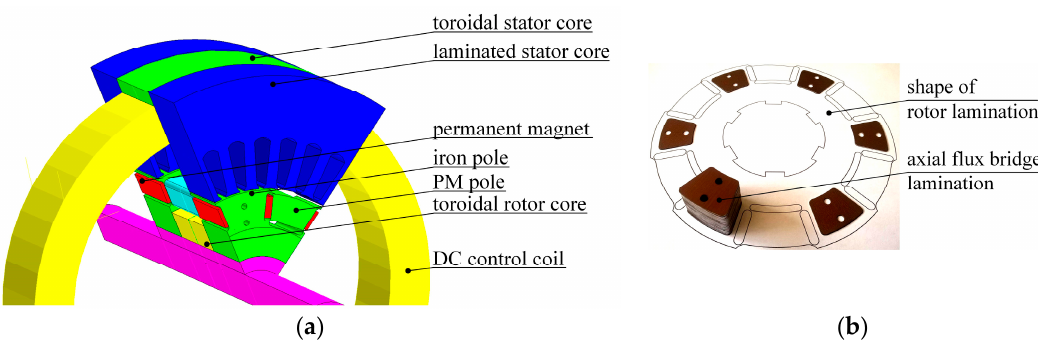
Figure 1. 3D-FEA model ( a ); stack of axial bridge lamination using in a machine prototype ( b ).